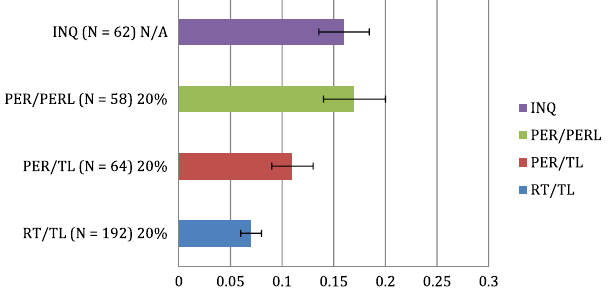
FIG. 5. Algebra-based BEMA normalized gain by laboratory and teaching style. The data are listed by laboratory and teaching style ( N ¼ number of students ) percentage total grade allotted to laboratories plus recitation . Lab styles are labeled by traditional (T), Real Time Physics (RT), combination RT and T (RT-T), developed at the University of Illinois (IL), and locally written PER-informed (PER). The lecture teaching styles are labeled by traditional lecture (TL), PER-informed lecture (PERL), and inquiry-based instruction (INQ). Honors sections are labeled with an H .